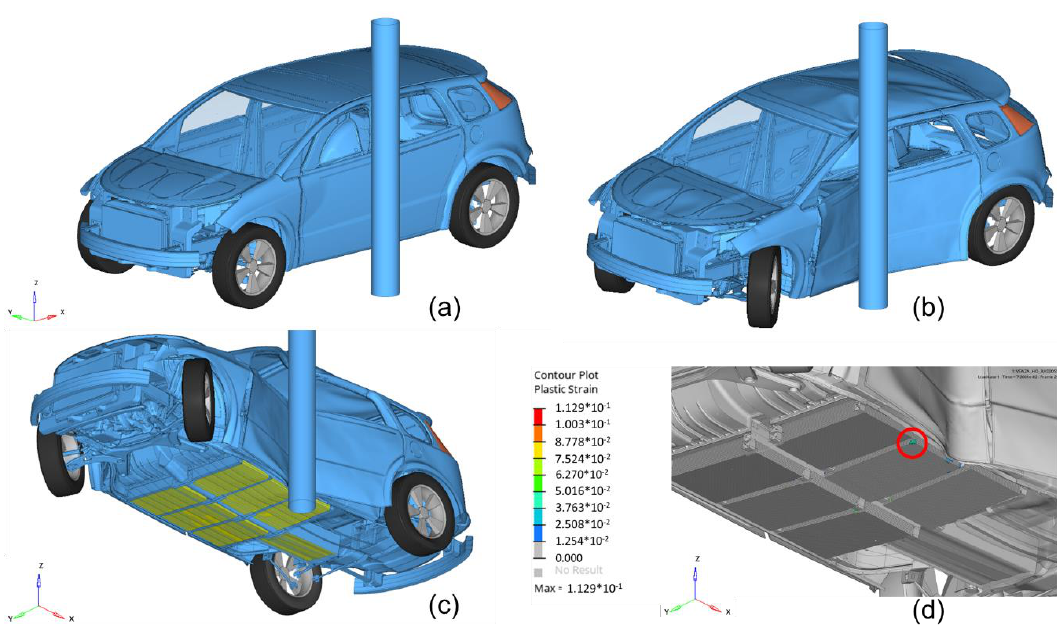
Figure 1. European side impact with 8.9 m/s initial velocity against a rigid pole: ( a ) front view before impact at time = 0 ms; ( b ) maximal intrusion at time = 70 ms; ( c ) bottom view showing battery package (yellow) and transparent ground floor at maximal intrusion; ( d ) plastic strain at the battery package. The red circle indicates the area with large plastic deformation.